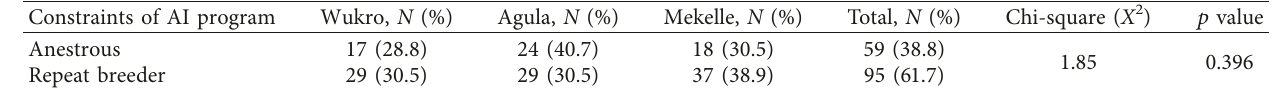
Table 5: The major constraints of the AI program in the study area.